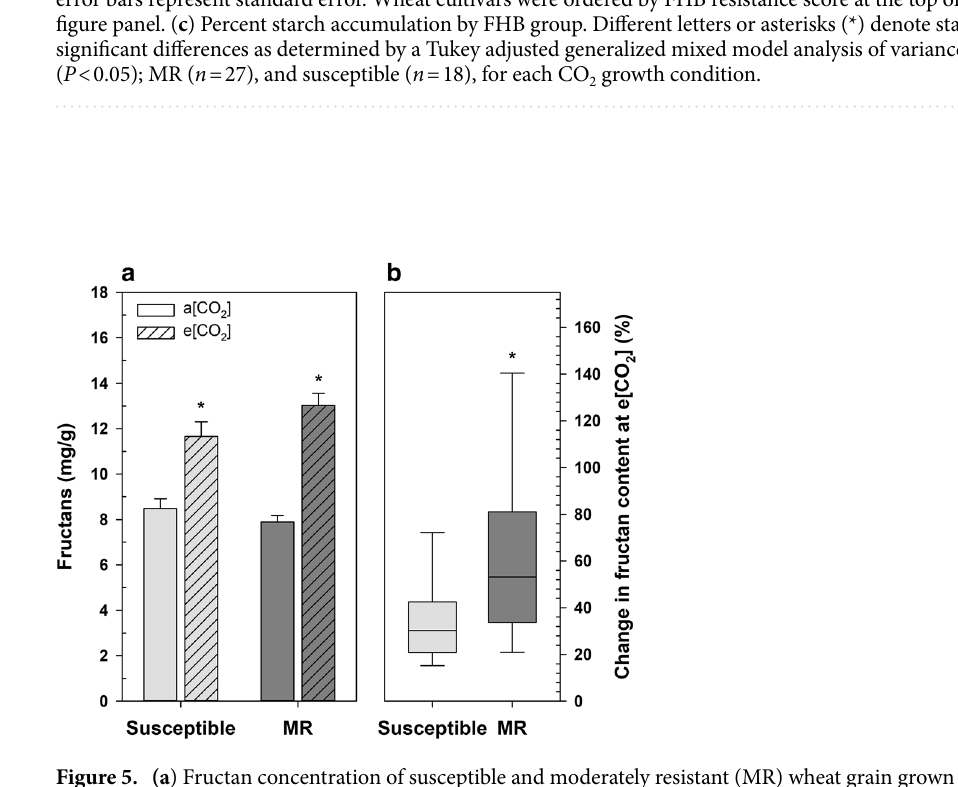
Figure 5. (a ) Fructan concentration of susceptible and moderately resistant (MR) wheat grain grown at ambient CO 2 (a[CO 2 ]) and elevated CO 2 (e[CO 2 ]), error bars represent standard error. ( b ) Percent change in fructan content at e[CO 2 ] by Fusarium head blight (FHB) resistance group. An asterisk (*) denotes a statistically significant effect of elevated CO 2 on Fructan concentration as determined by Tukey adjusted generalized mixed model analysis of variance ( P < 0.05); MR ( n = 27), and susceptible ( n = 18), for each CO 2 growth